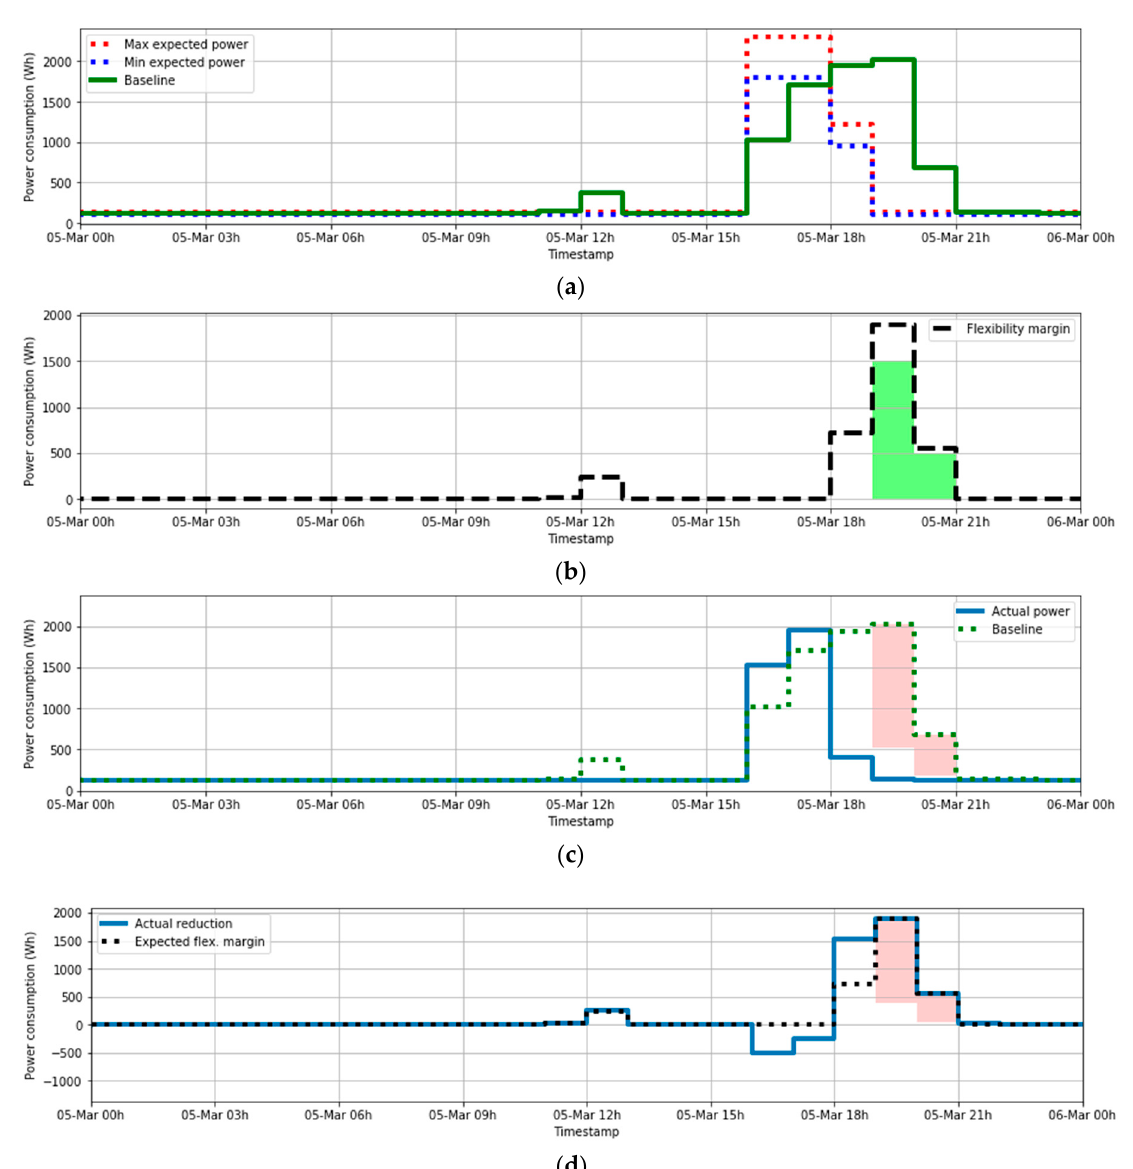
Figure 10. ( a ) Occupancy-based (from BMS) and historical-based (baseline) expected power; ( b ) Expected flexibility Margin (only values >0). Reduction really requested by the DSO (in green); ( c ) Actual power and baseline. Requested power reduction (in red); ( d ) Reduction achieved vs. Expected flexibility margin. Requested power reduction (in red).